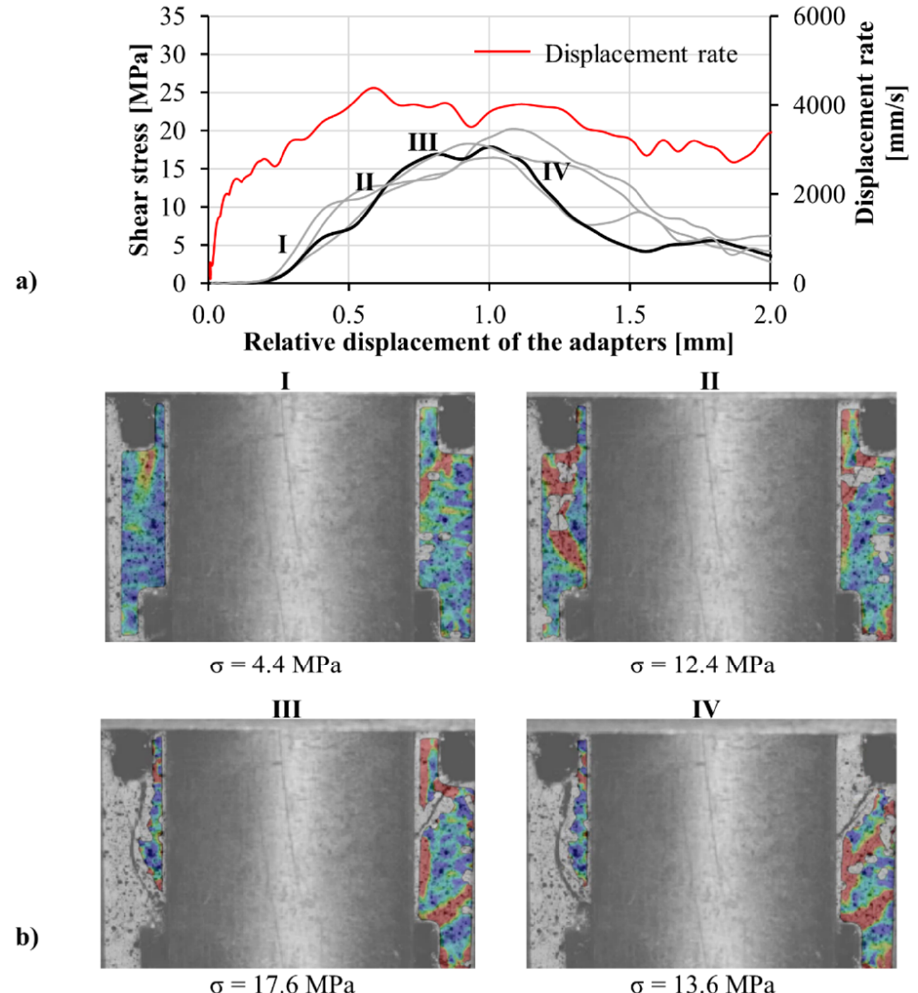
Figure 18. ( a ) Shear stress versus displacement curves obtained in the unconfined impact shear tests on M1-6PE SHCC, and ( b ) a representative DIC sequence showing the first principal strain field in the shear zones for various stress levels corresponding to the thicker black curve.